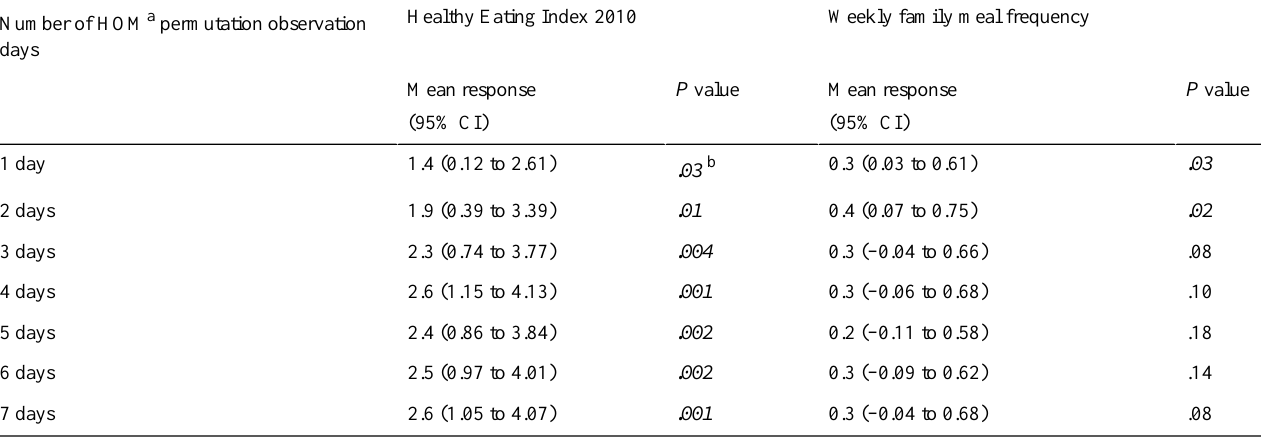
Table 1. Association between the number of direct observation days in the healthfulness of meal index permutation and the Healthy Eating Index 2010 and weekly family meal frequency: (N=120) households (caregivers and children) recruited from Minneapolis–St Paul primary care clinics between 2012 and 2013.